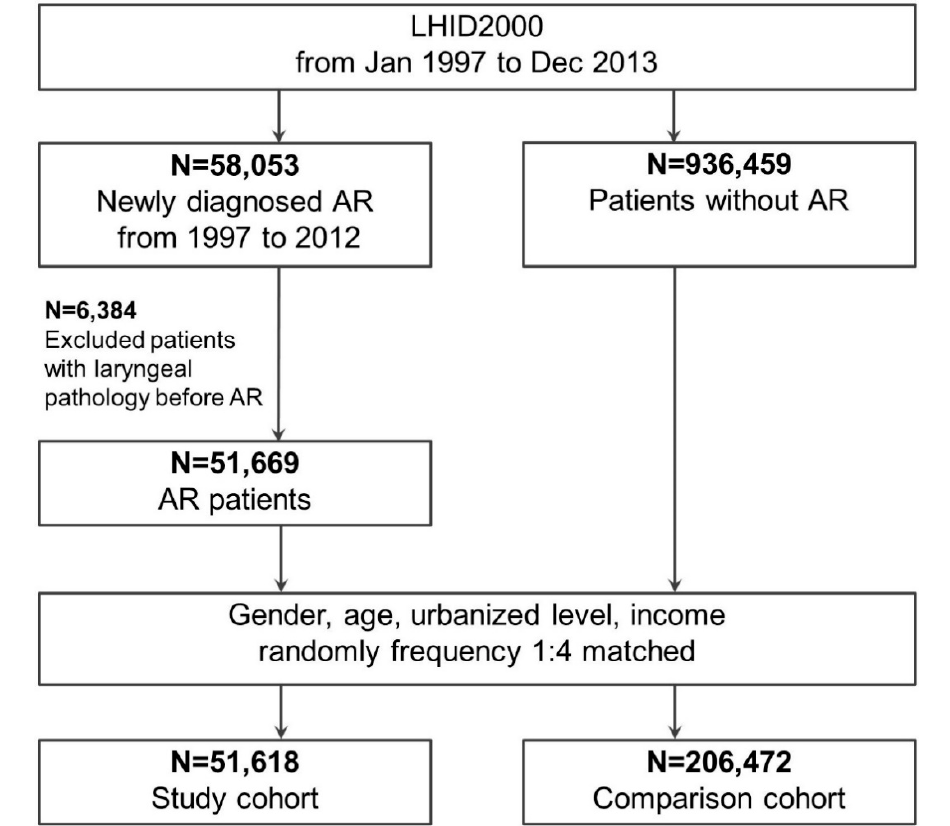
Figure 1. Identification and enrollment of participants. Abbreviations: AR, allergic rhinitis; LHID 2000, Longitudinal Health Insurance Database 2000.